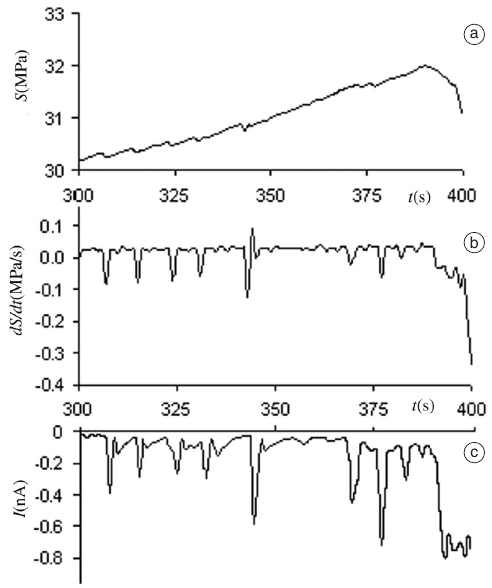
Fig. 9a-c. Multiple PSC peaks of a marble sample (MD016) in the time interval of the appearance of mi- crocracks (parallel to the direction of the applied stress) and fracture time: a) stress, b) stress rate and (c) PSC.